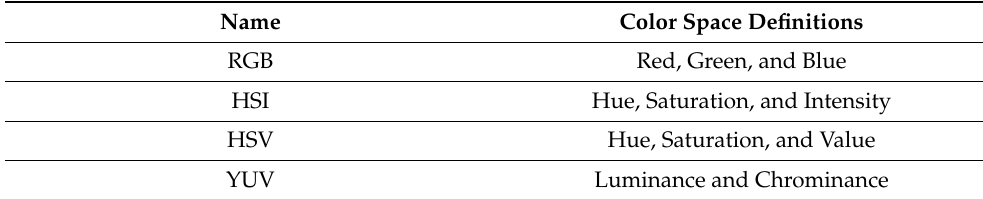
Table 2. Selected color models and their